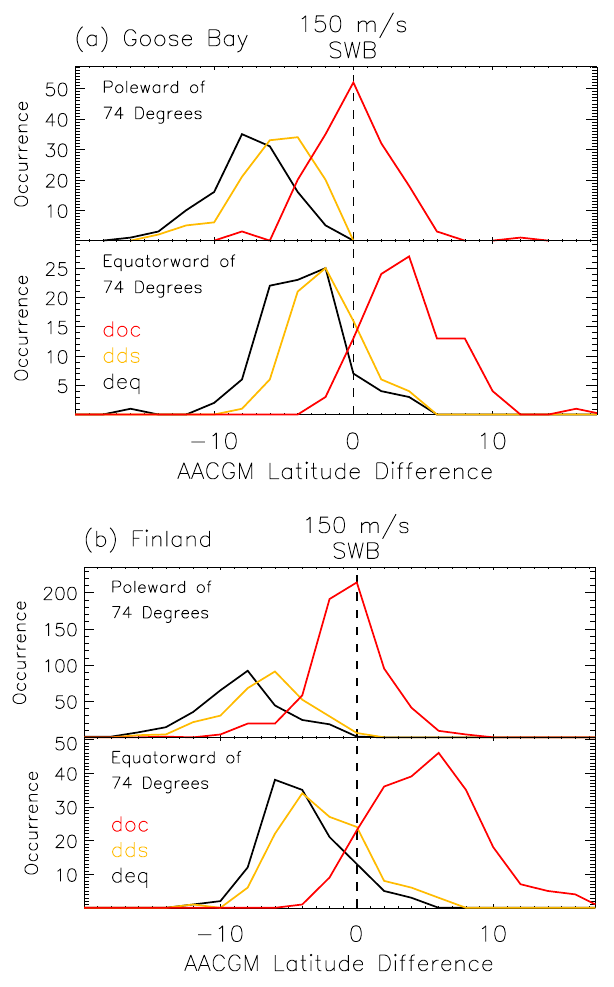
Fig. 2. Occurrence distributions of latitude differences between the DMSP PPBs and the 150m/s threshold SWB for the (a) Goose Bay, and (b) Finland SuperDARN radars in the 12:00–18:00 MLT re- gion. The upper panels represent the results from comparisons us- ing SWBs located poleward of 74 ◦ , whereas the lower panels repre- sent the results from comparisons using SWBs located equatorward of 74 ◦ . The three different distributions in each panel are for the different PPBs: deq (black), dds (yellow), and doc (red).